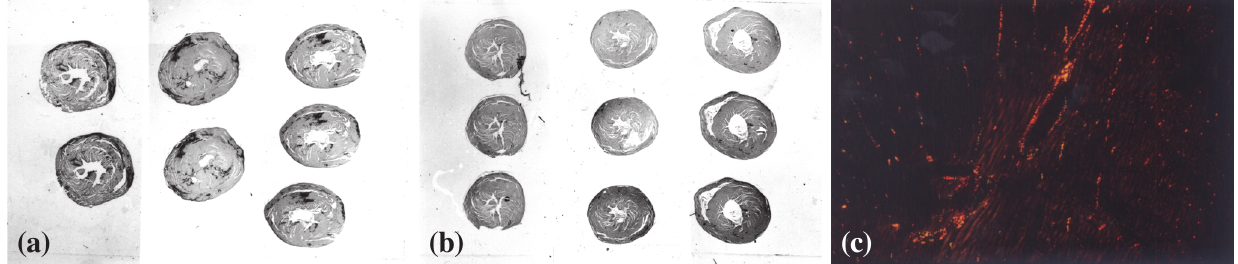
Figure 1 - Panoramic view of heart sections showing hypertrophy and fibrotic scars (dark areas) in the hypertensive hearts (a) compared with control hearts (b) stained with picro-sirius red; (c) myocardium of a control animal showing fibrillar collagen (in yellow, orange, or red) corresponding to a high proportion of collagen, with a small amount of reticular collagen (in green) (magnification 100X) (picro-sirius red polarization).